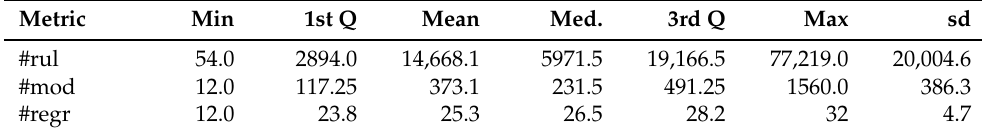
Table 7. Descriptive statistics of the experiment runs for the credit